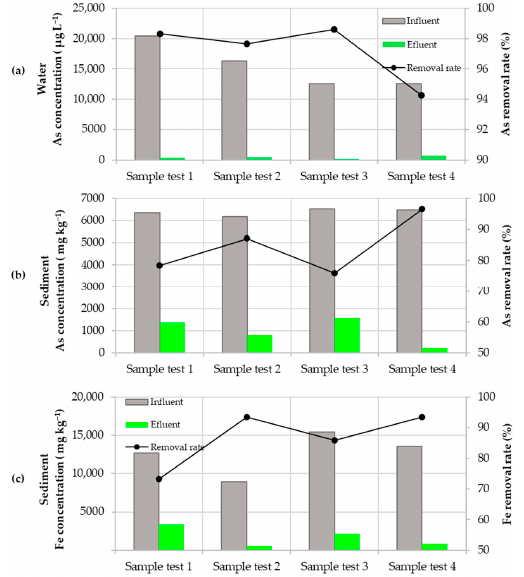
Figure 5. As removal in: ( a ) water; ( b ) sediments and ( c ) Fe removal in sediments.